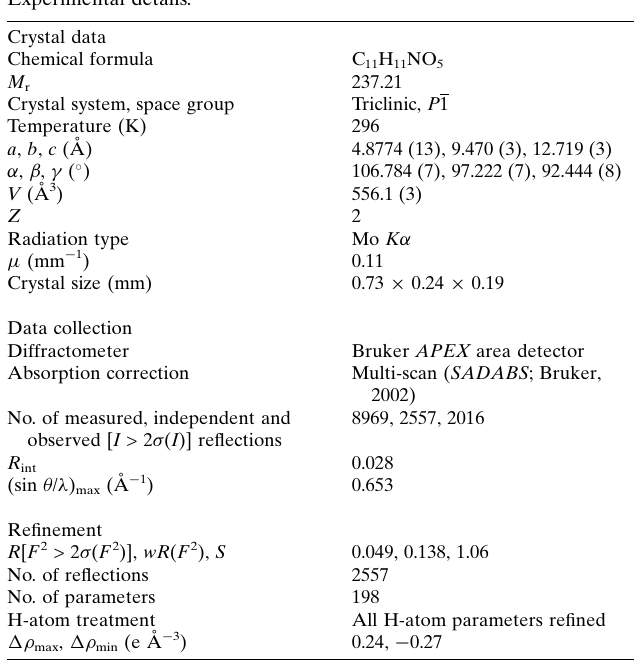
Table 2 Experimental details.